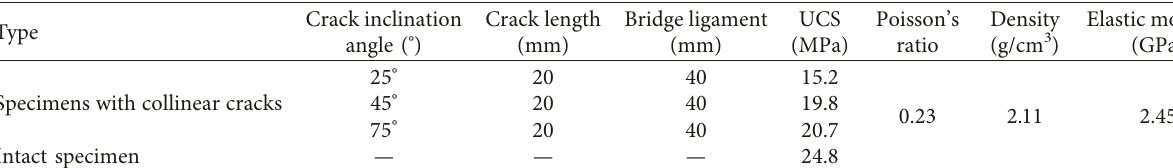
Table 1: Material properties of the